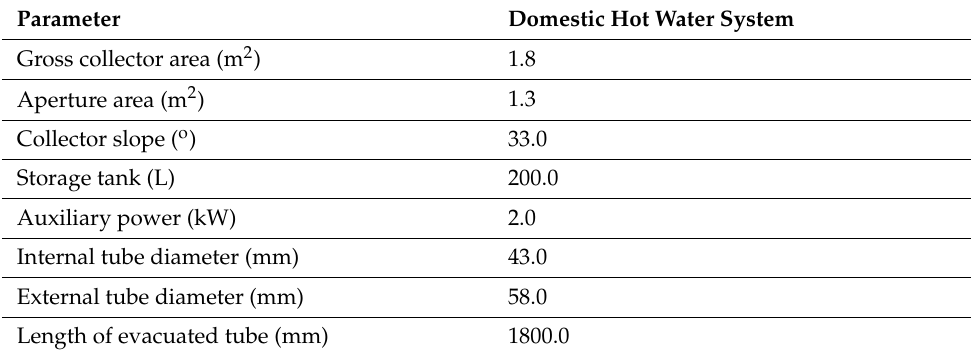
Table 2. Specifications of the SWH used in the